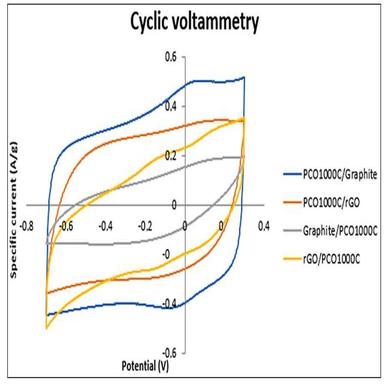
Cyclic voltammetry in H2SO4 at 1 M at 0.005 V/s.